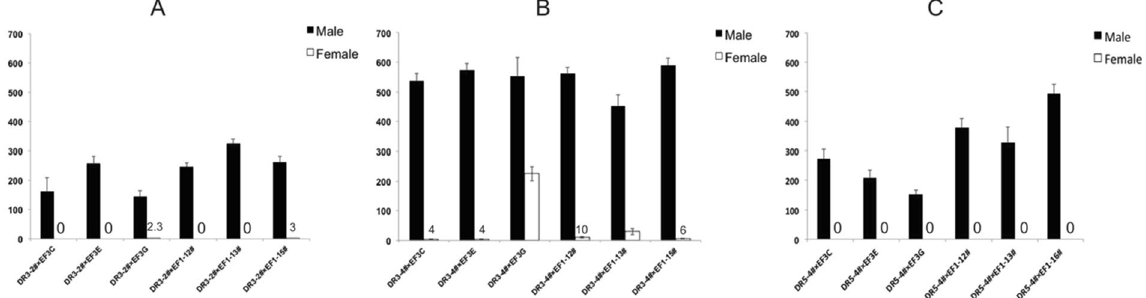
Figure 4. Female-specific lethality of double heterozygous lines. Homozygous DR3#2 ( A ) and DR3#4 ( B ) males were crossed with virgin females from each of the indicated homozygous effector lines. For the X-linked DR5#4 line ( C ), virgin females were crossed with males from each homozygous effector line. The offspring of the crosses were raised on diet without tetracycline. Error bars show the standard error of the mean (n = 3).